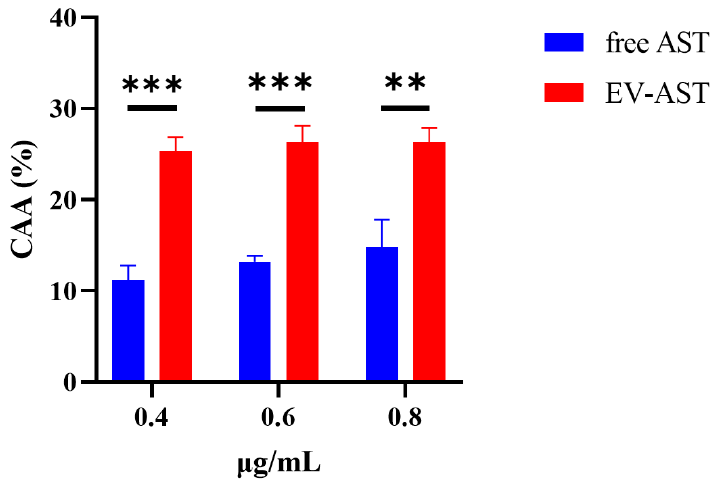
Figure 6. Measurement of CAA in free AST and EV ASTs. The CAA (%) of free AST and EV-AST was determined at different concentrations (0.4, 0.6, and 0.8 μg/mL) in HaCaT cells (**: p < 0.01; ***: was determined at different concentrations (0.4, 0.6, and 0.8 µ g/mL) in HaCaT cells (**: p < 0.01; p < 0.001). ***: p <